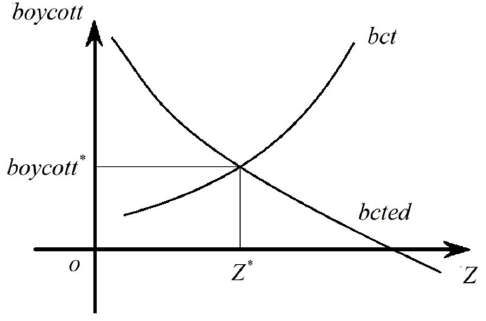
Figure 1. Decision to Equalize Emissions. Note: ( Z *, boycott *) is the pollution emission of enterprises and the intensity of residents’ boycott at the equilibrium point.